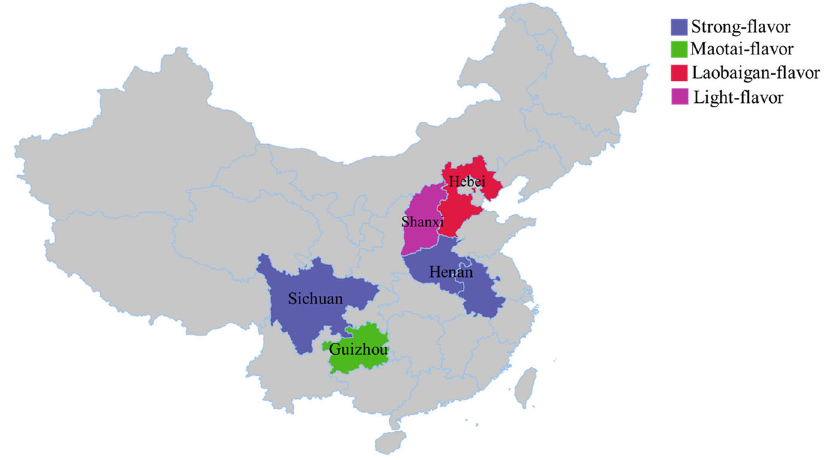
Figure 1. Regional distribution of four types of Baijiu in China.